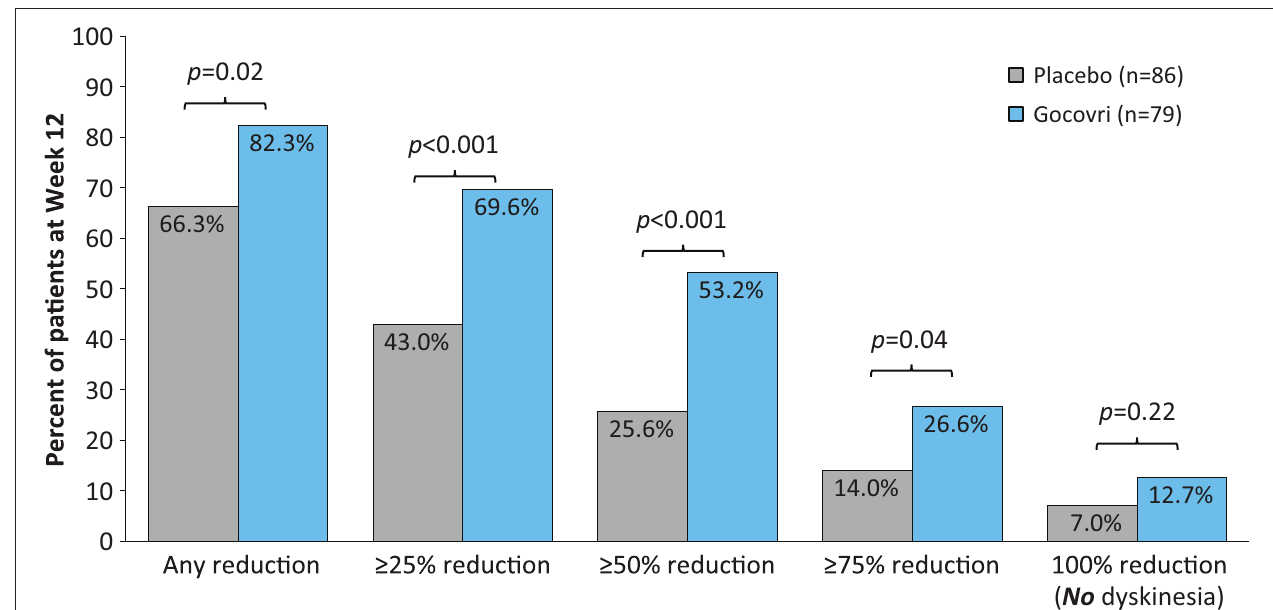
FIGURE 2 | Distribution of patients achieving ≥ 25%, ≥ 50%, ≥ 75%, and 100% reductions in ON time with dyskinesia (both troublesome and nontroublesome). Two-sided p -values were obtained post-hoc using the Farrington-Manning (FM) score test for H0: Delta = 0, where Delta is the treatment difference in responder rates.